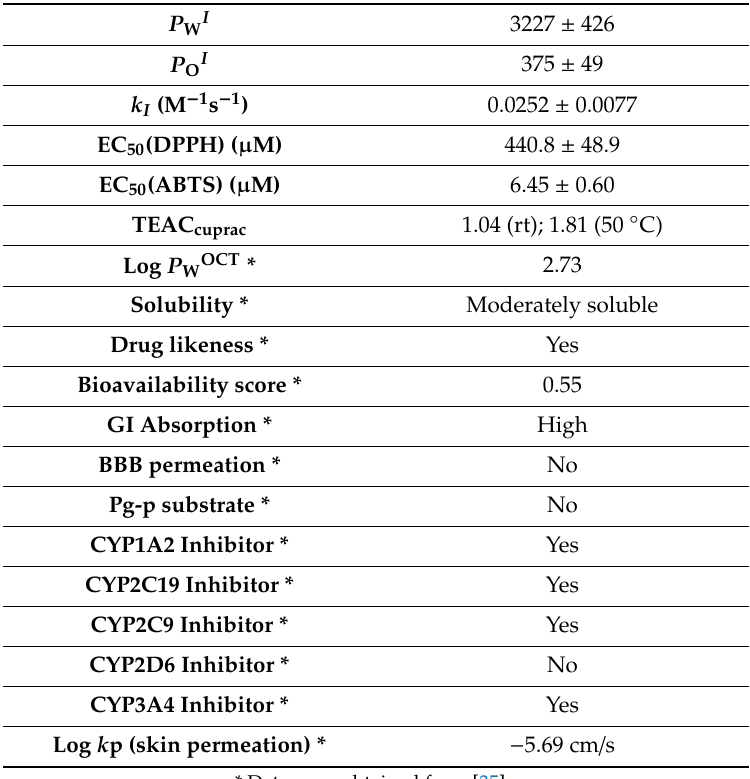
* Data were obtained from